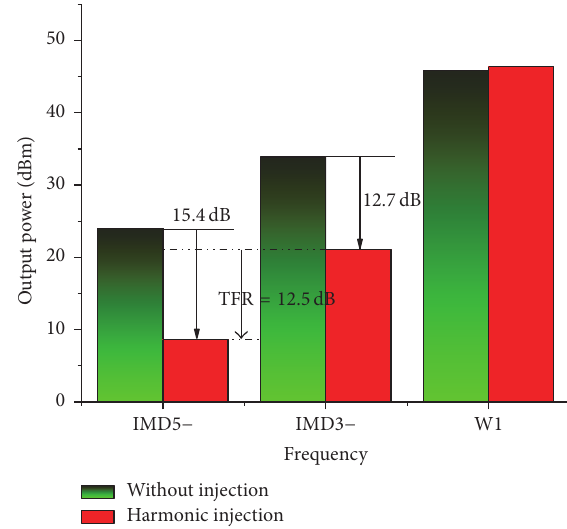
Figure 11: The output signal spectrum under optimal 2HD injection of simultaneous suppression for IMD3 and IMD5. Table 1: The output power, suppression, and corresponding TFR under optimum IM3 injection and 2HD injection in simulation.